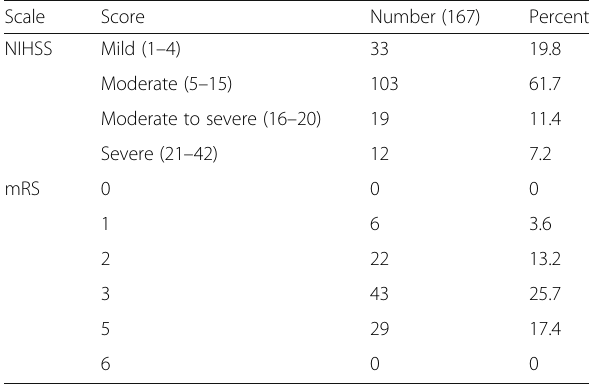
Table 2 Results of NIHSS and mRS in 167 ischemic stroke patients